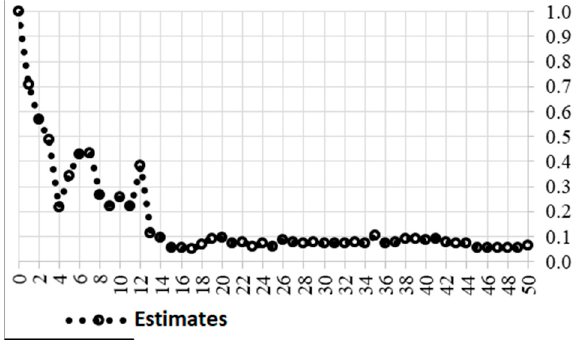
Figure 2. Step-by-step estimates of the transport table .